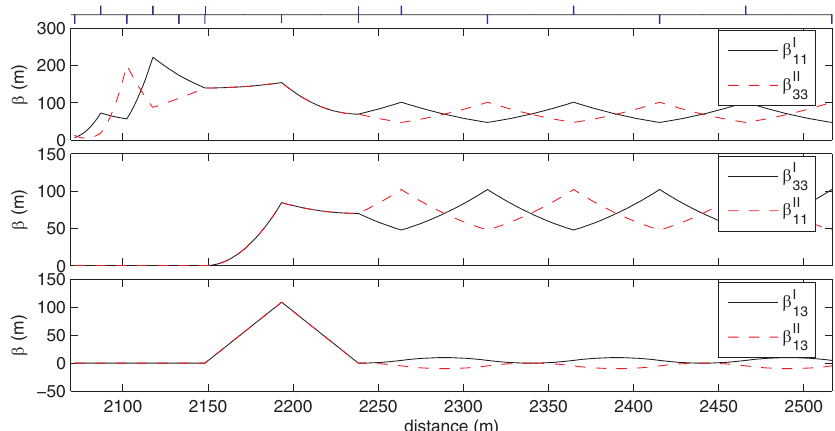
FIG. 1. (Color) Coupled lattice functions in a flat-beam to round-beam